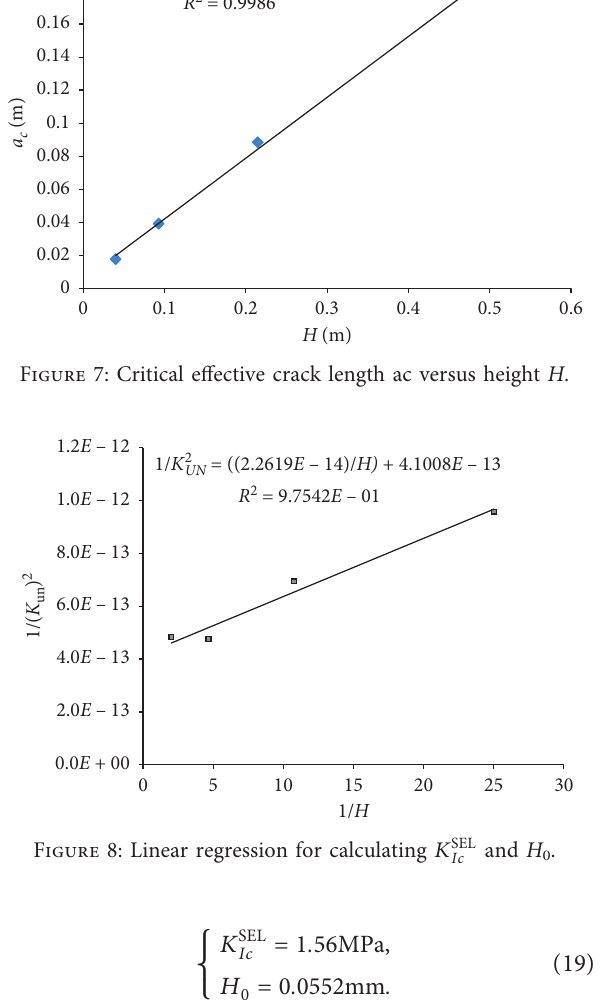
Figure 10: Variation in ratio ( Δ r / a